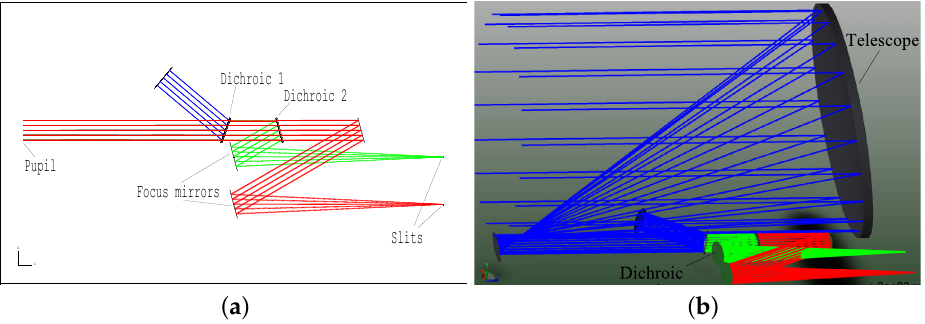
Figure 6. ( a ) Dichroic system. ( b ) Shaded model of dichroic system combined with telescope. CH1 channel, green; CH2, red; pointing system, blue.